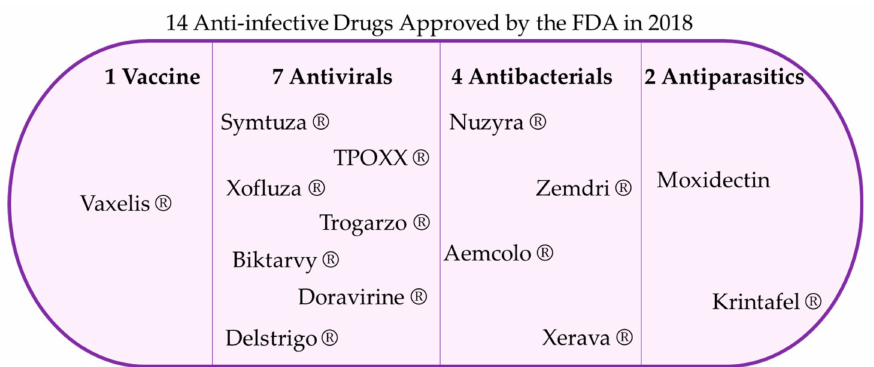
Figure 1. Anti-infective drugs approved by the FDA in 2018.